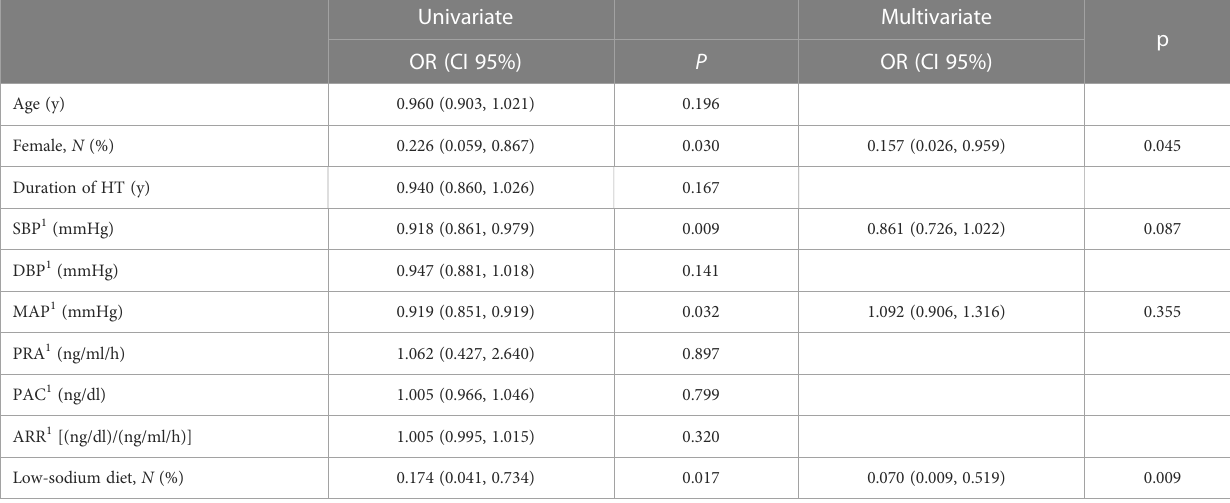
TABLE 5 Multiple regression analysis of factors in fl uencing BP after the dietary intervention.